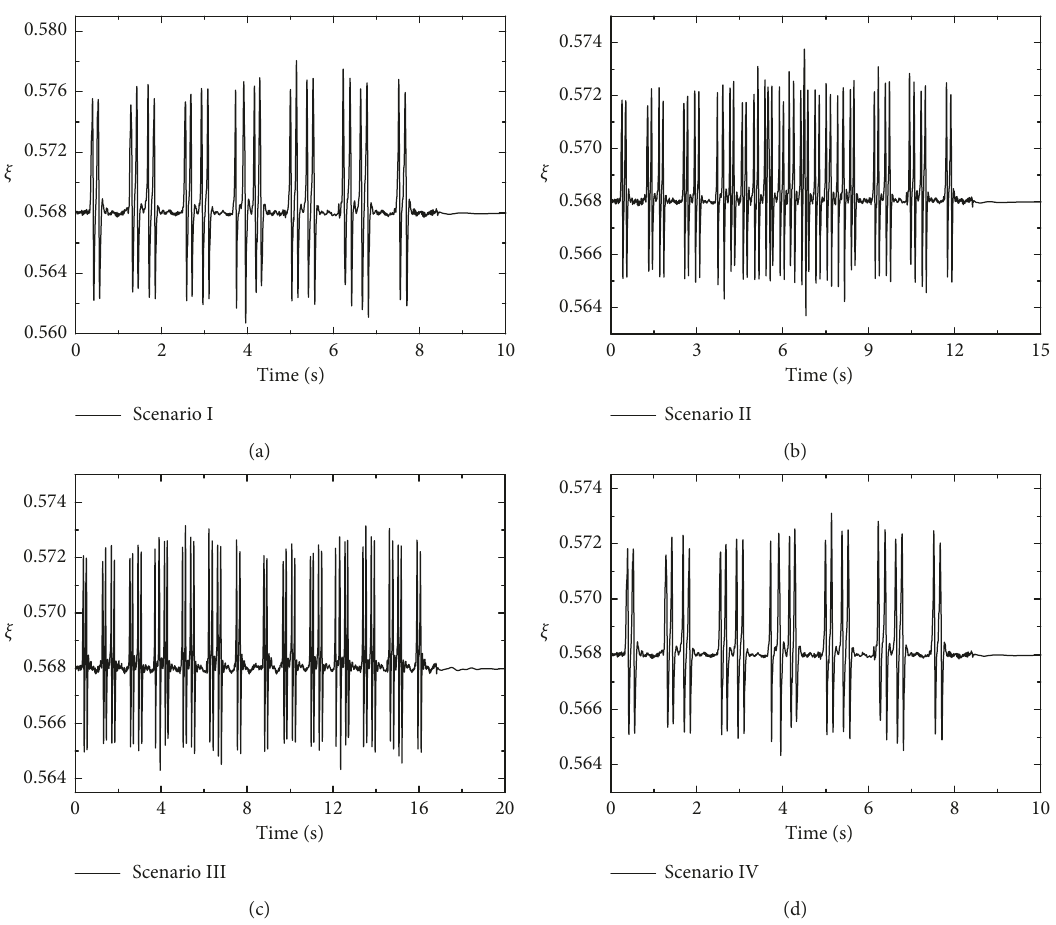
Figure 20: ξ value trends of A 1 . (a) Scenario I. (b) Scenario II. (c) Scenario III. (d) Scenario